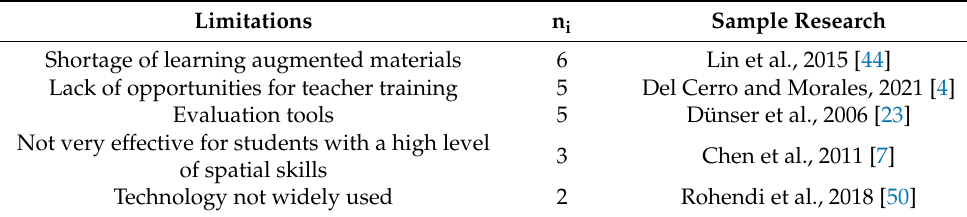
Table 9. Limitations of AR in improving spatial